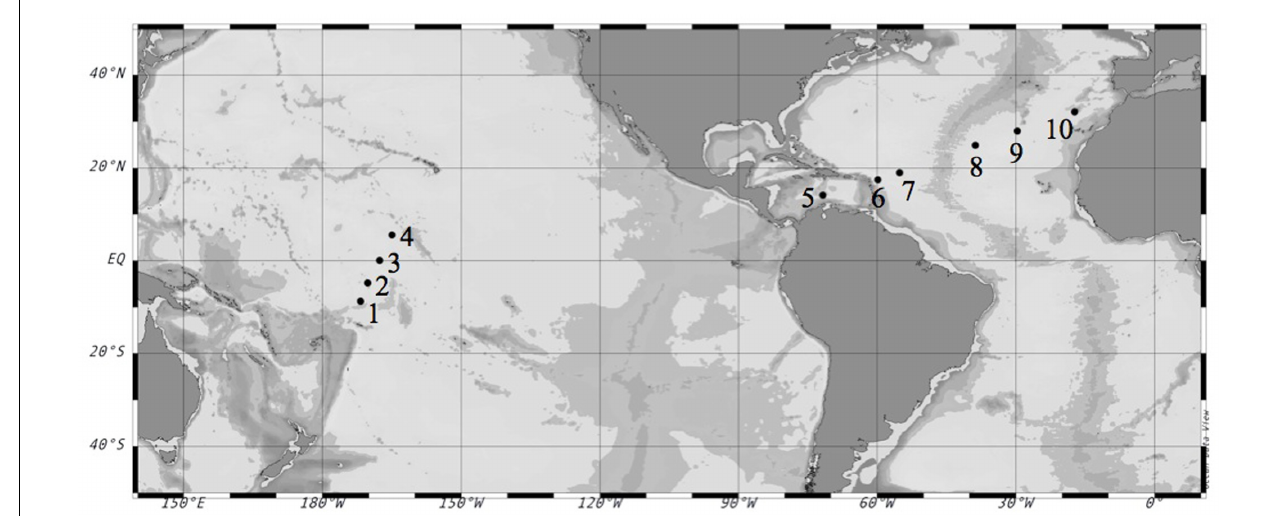
FIGURE 1 | Location of the selected stations during the Malaspina-2010 Expedition where the experiments were performed. Circles mark the number of each experiment. Coordinates are reported in Table 2 .